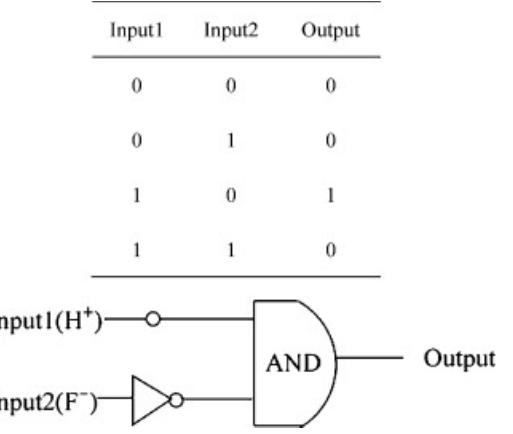
Figure 14. General description of an INH gate and the subsequent truth table (0 means low signal, 1 means high signal) (reprinted with permission from [149]).